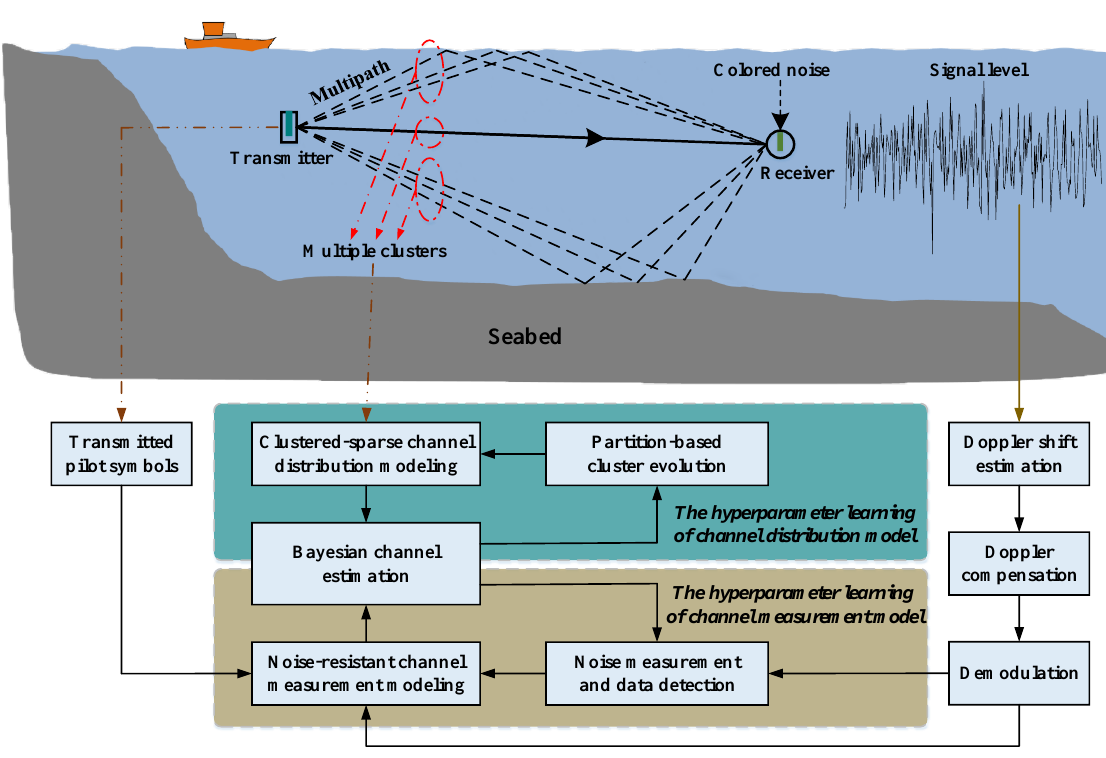
Figure 2. Architecture of Bayesian learning-based channel estimation in UWA-OFDM